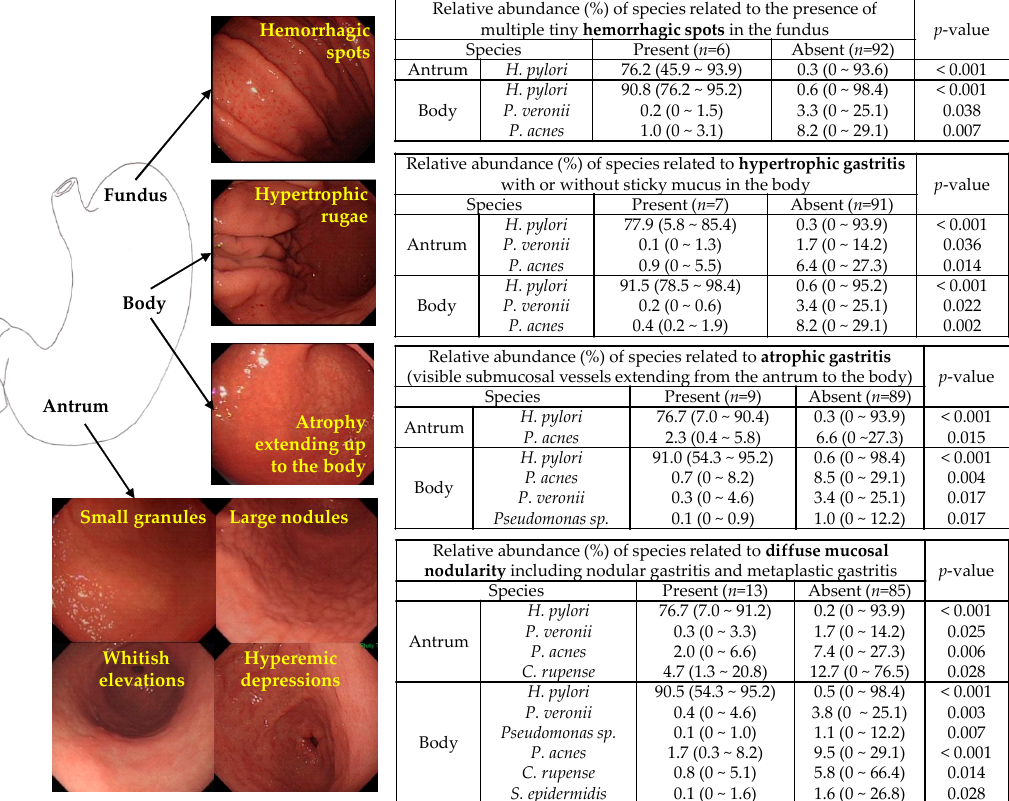
Table 3. Gastric and duodenal microbiota correlated with the Patient Assessment of Gastrointestinal